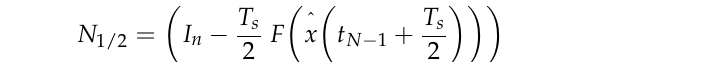
( b ) Figure 9. ( a ) Concentration C (cid:2913) (y = (cid:2921) (cid:2895) L (cid:2913) , t) = C (cid:2913)(cid:2924) (y (cid:2924) ,t) C (cid:2928)(cid:2915)(cid:2916) as a function of time and k . ( b ) Concen- tration C (cid:2917) (x = (cid:2914) (cid:2888) h (cid:2914) , y = (cid:2921) (cid:2895) L (cid:2913) ,t) = C (cid:2917)(cid:2924) (x (cid:2924) , y (cid:2924), , t)C (cid:2928)(cid:2915)(cid:2916) as a function of time and d , and two values of k = 0 and k = K = 20 . Figure 10 shows the variation of the estimated parameters with time. Figure 10a shows the variation of potential η as a function of time for different values of k . The value of potential η follows the PEMFC current values. The hysteresis phenomena can be observed on the potential curve for the forward/backward sweep. As illustrated in Figure 10b, the capacitances C (cid:2888)(cid:2896) vary slightly. As presented in Figure 10c, the estimated resistance r Ω increased hardly for the forward sweep and for the backward sweep, it was still constant. This could be attributed to the FC’s temperature as well as to hydration. A proper water content in a fuel cell will reduce the membrane resistance and promote the